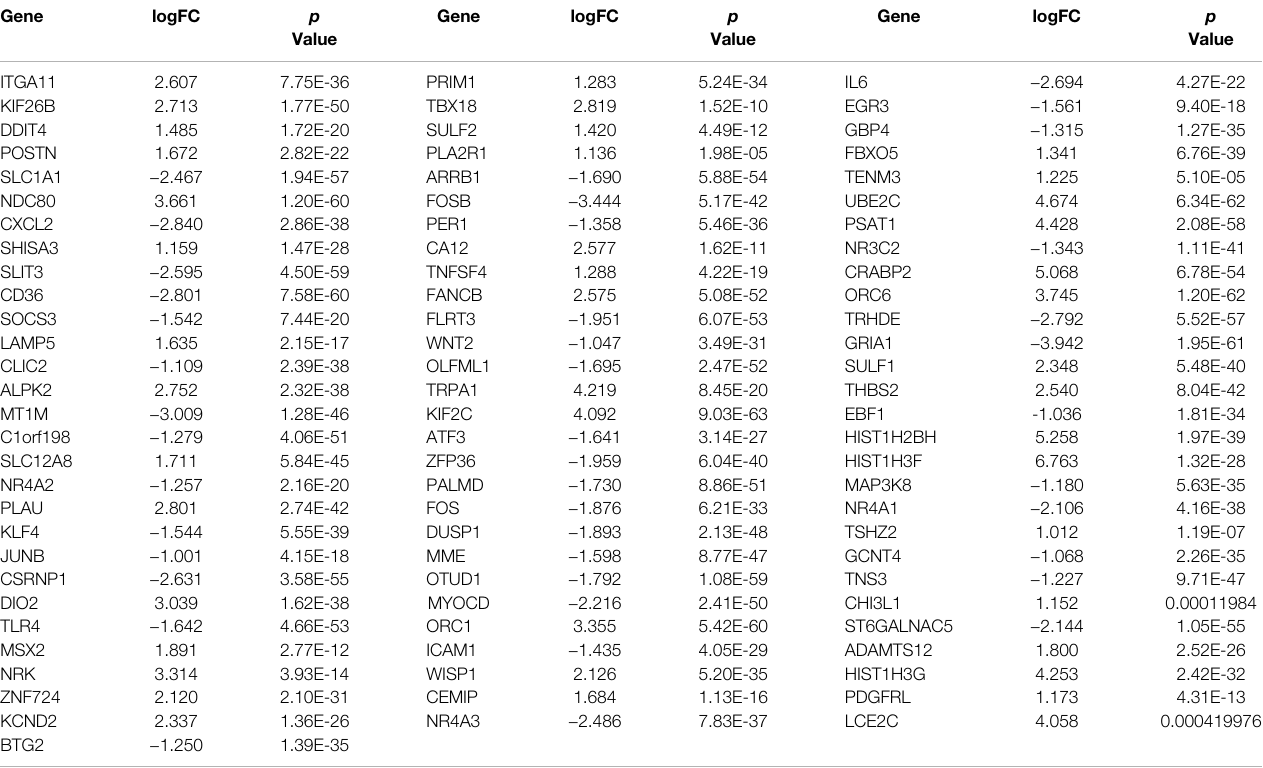
Gene logFC p Value